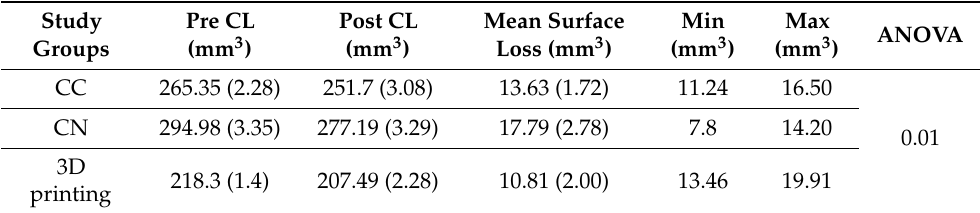
Table 5. Surface wear among interim restorative samples in the study groups. CC: CAD-CAM, CN: conventional, 3D: 3D printing, CL: cyclic loading.